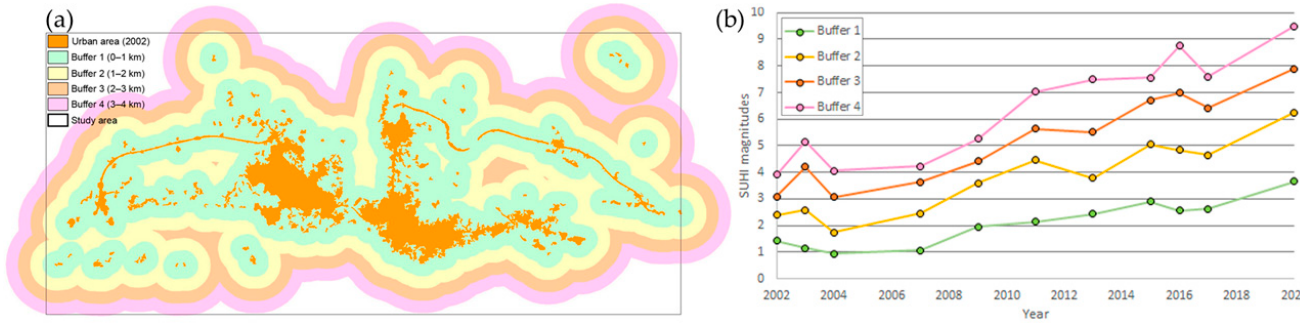
Figure 7. The 2002 urban area and buffer rings with 1 km intervals ( a ) and the buffer SUHI magnitudes between the years 2002 and 2020 ( b ).